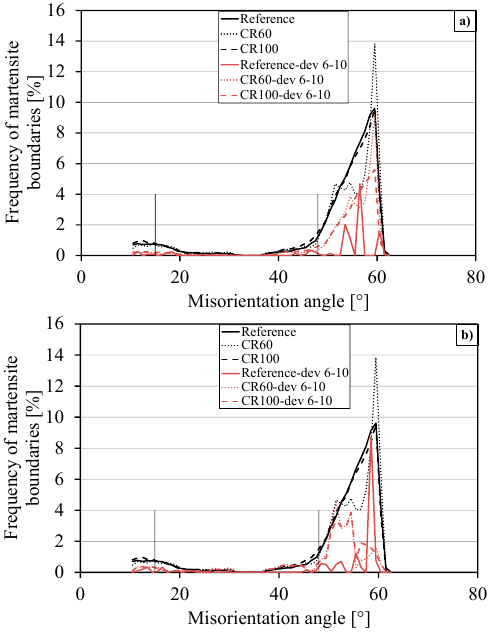
Figure 3. The frequency distribution of martensite boundaries and their deviation from ( a ) the axis and ( b ) the angle for the misorientation angle between 10.5° and 63°.